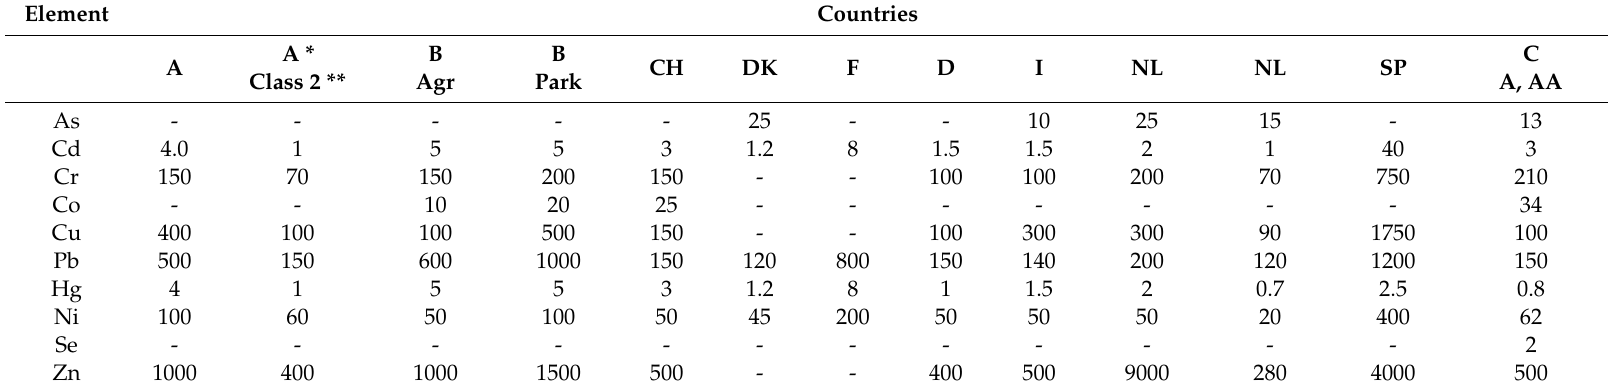
Table 12. Heavy metal limits (mg / kg) in compost for European countries with compost rules as taken on from [99].